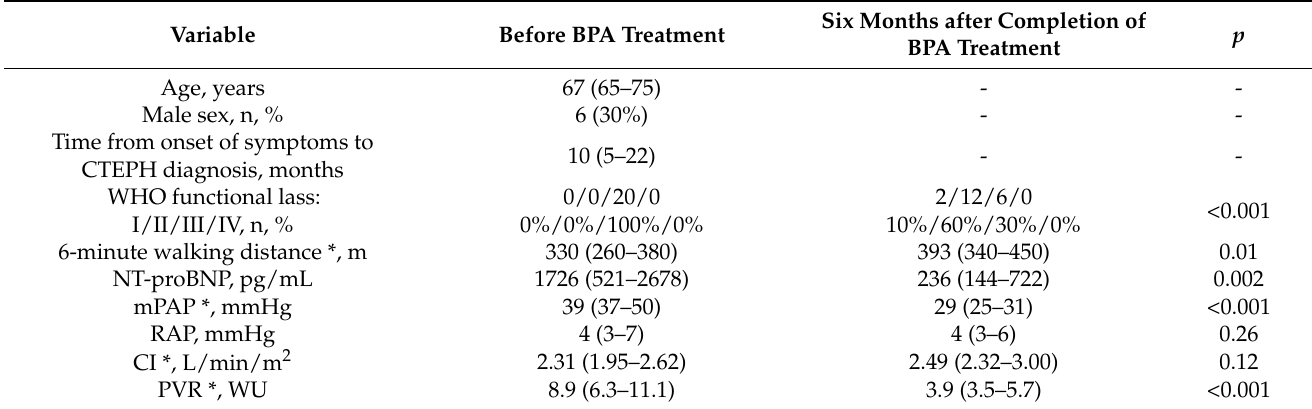
Table 1. Clinical and hemodynamic characteristics of patients with chronic thromboembolic pul- monary hypertension (n = 20).